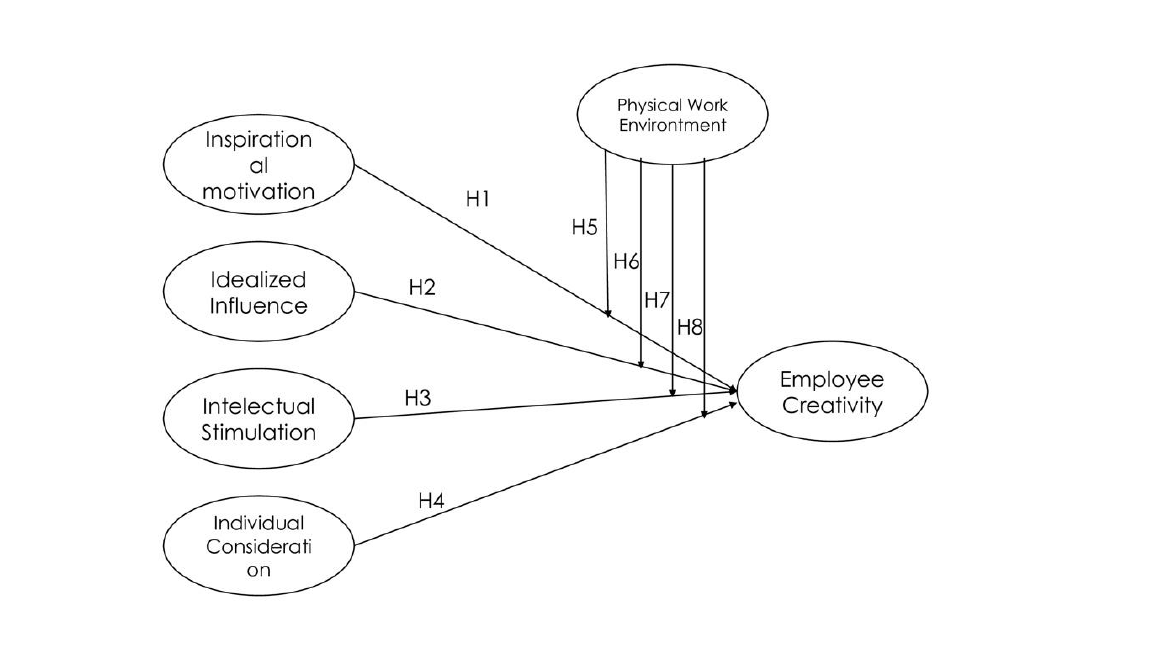
Figure 1. Research Framework